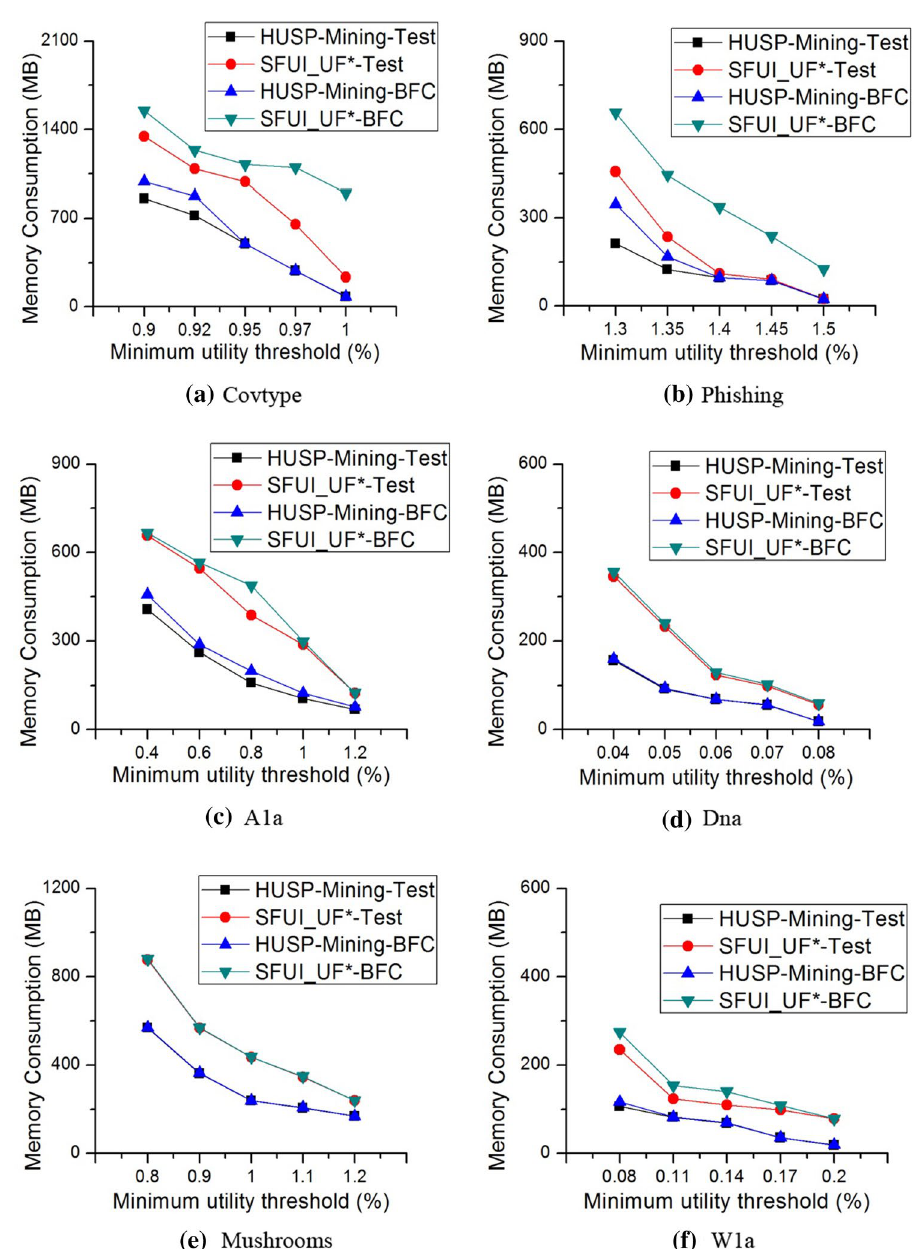
Fig. 12 Memory consumption comparisons of